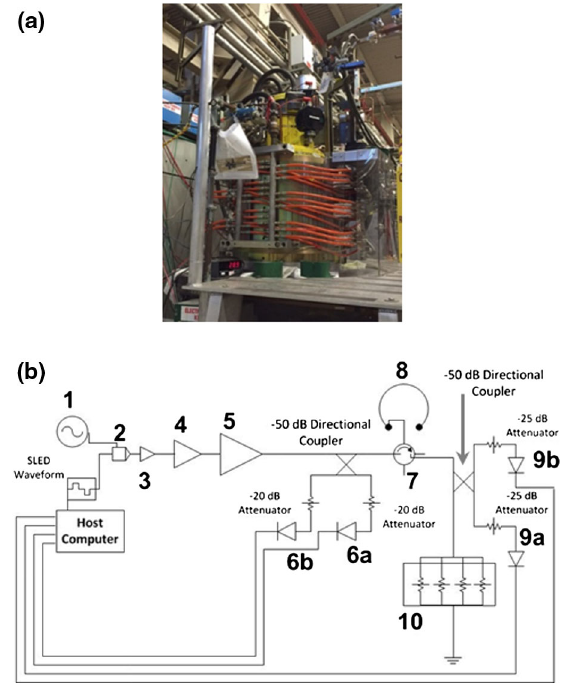
FIG. 13. (a) Photograph of the XL-4 klystron used to test the SLED cavity and (b) a circuit diagram of the experimental setup: (1) local oscillator, (2) arbitrary function generator (AFG), (3) 20db amplifier, (4) traveling wave tube, (5) SLAC XL4 klystron, (6a-6b) peak power meters before SLED, (7) polarizer, (8) SLED, (9a – 9b) peak power meters after SLED, and (10) high power